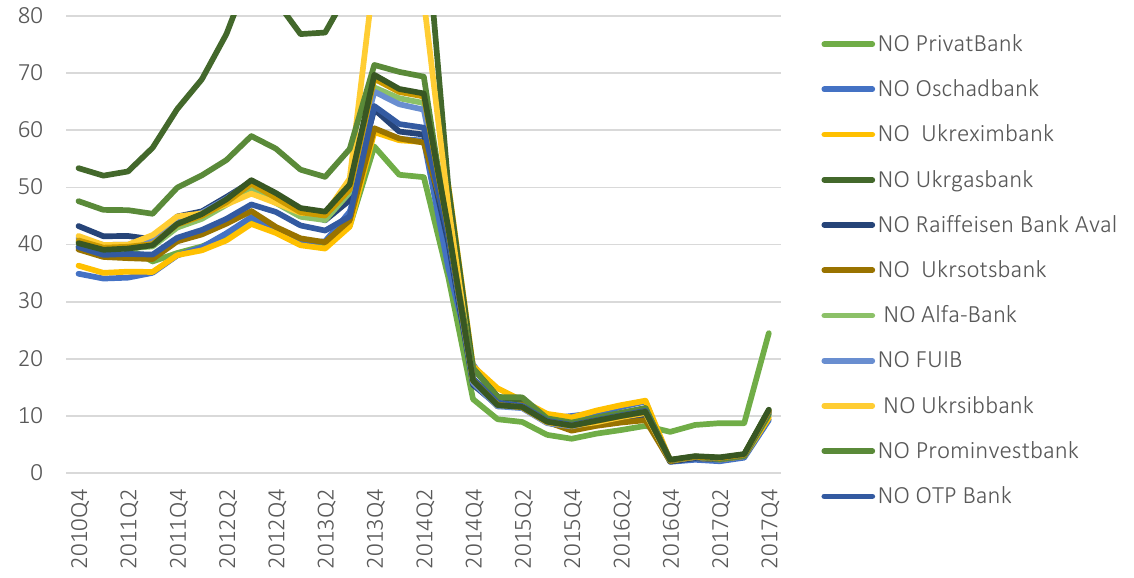
Figure 2. Trends in aggregated Z-scores and minus one bank Z-scores for Ukrainian banks, calculated using Approach 1